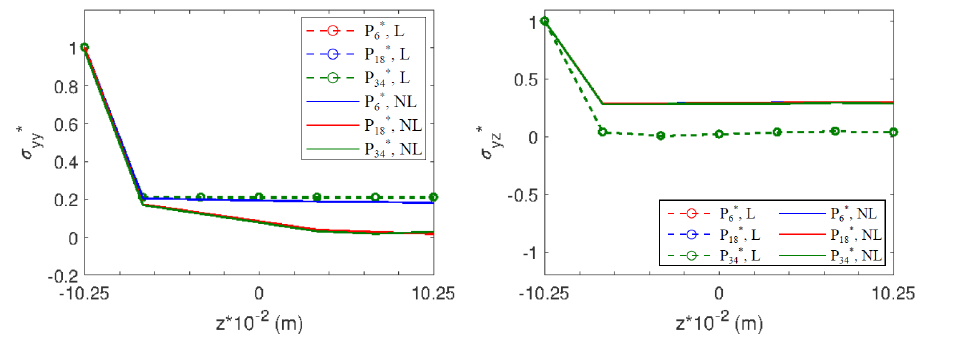
= − 3.3 − 4 , P ∗ = − 2.9 − 3 , 6 18